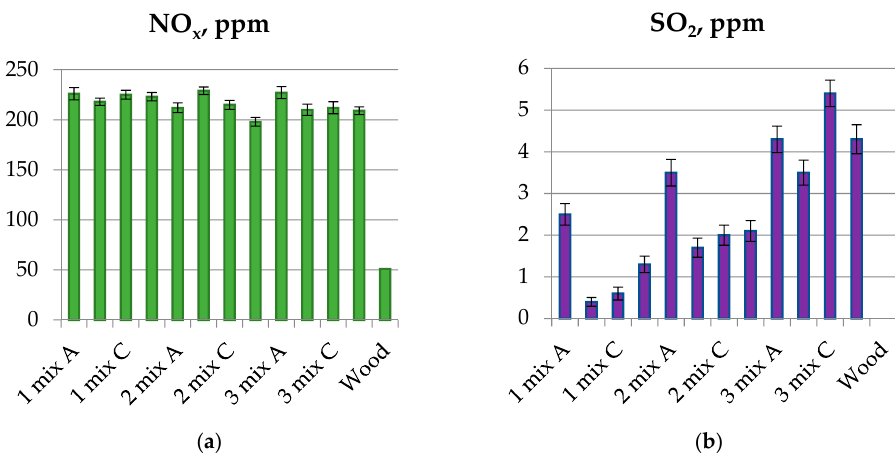
Figure 8. NO x ( a ) and SO 2 ( b ) emissions from burning of granulated faba bean waste and potato peels. From the obtained results, it was found that the CO 2 emissions directly depend on the oxygen content in the fuel (Figure 6). The correlation coefficient was 0.96. The deter- mined carbon dioxide emissions were lower than those of wood pellets.